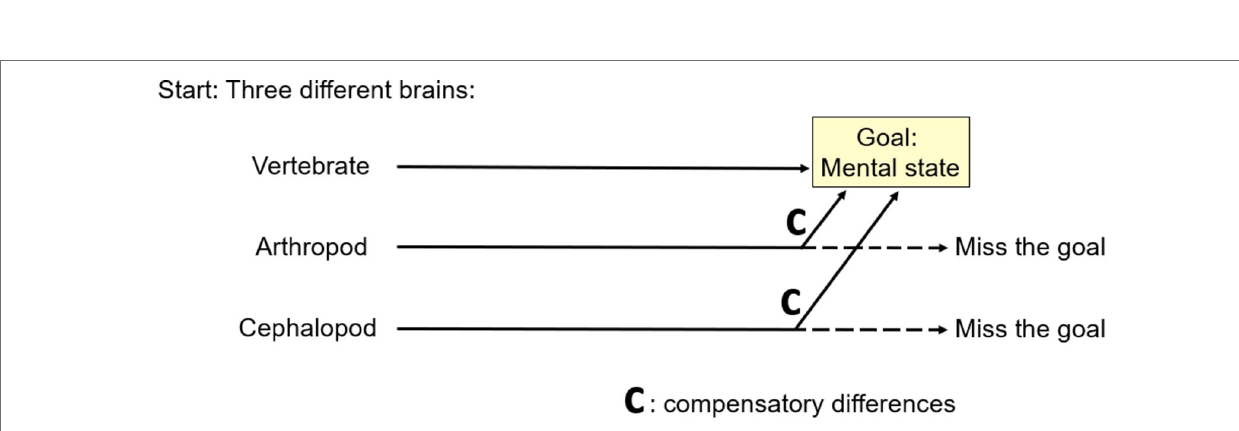
FIGURE 7 | A theoretical reason for multiple realizability by compensatory differences. If different animal lineages start from different places (left), then all but one must evolve compensatory differences if all are to reach a common goal